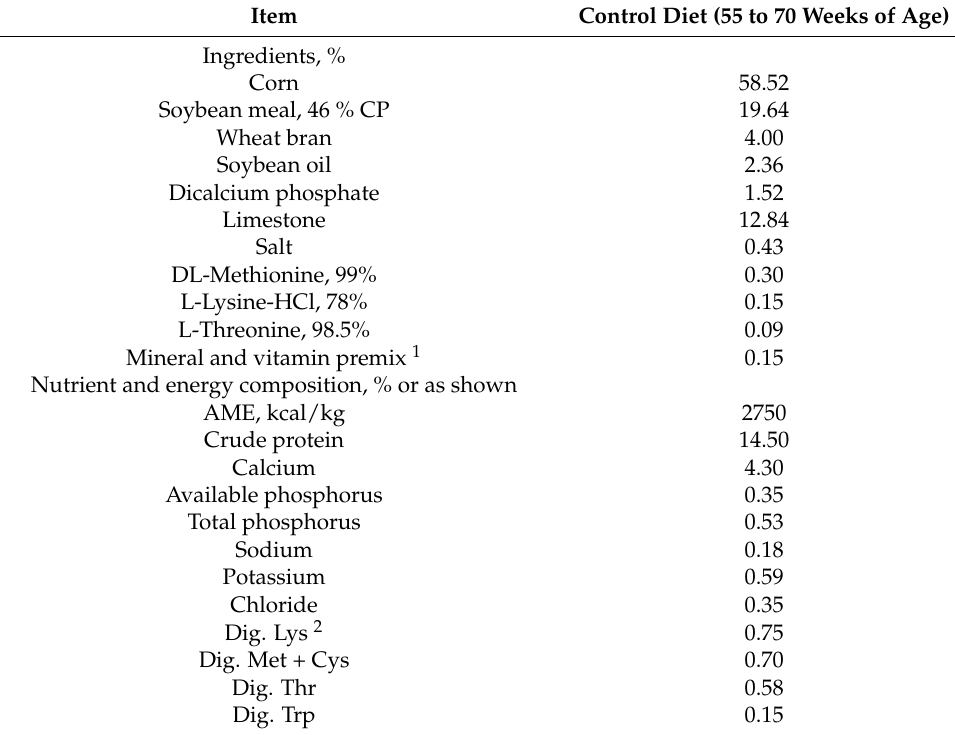
Table 1. Ingredient and nutrient composition of the control